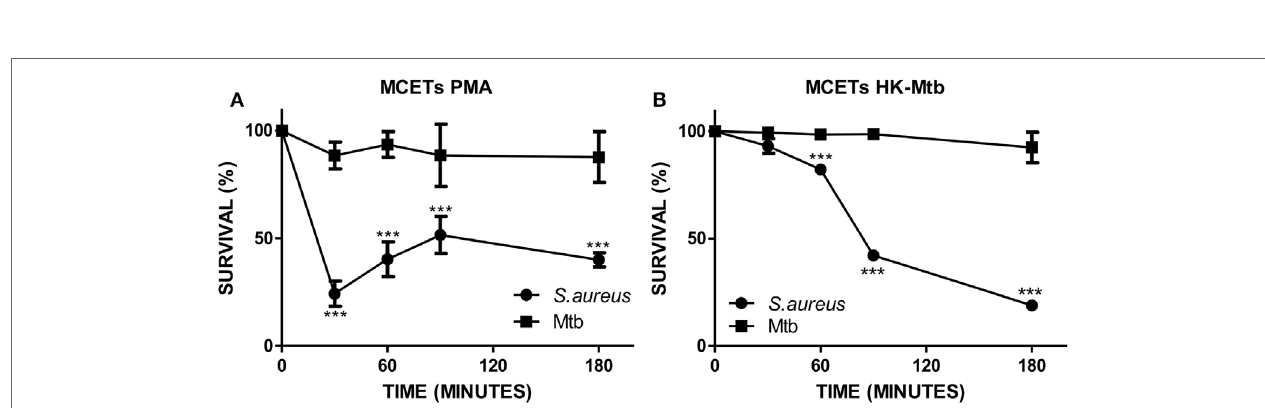
FigUre 3 | Mast cell extracellular traps do not kill Mycobacterium tuberculosis (Mtb). (a) HMC-1 cells were activated with PMA or (B) heat-killed Mtb (HK-Mtb) to induce MCETs, then Mtb or Staphylococcus aureus were added at a MOI of 1 for 3 h Bacteria survival was evaluated by CFU. *** p < 0.001 compared with the initial time.